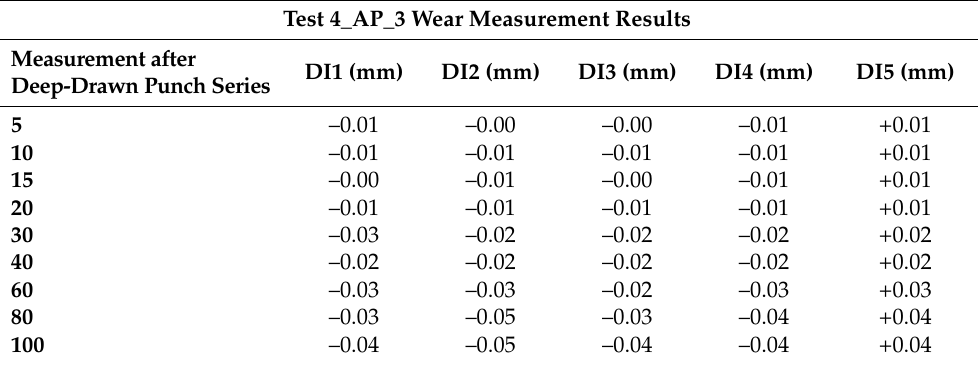
Figure 12. Wear of punch in Test 4_AP_3 between 5 ( left ) and 100 pieces ( right ). All values are in mm unit. Table 16. Wear of punch in Test 4_AP_3 between 5 and 100 pieces, measured values at given points.